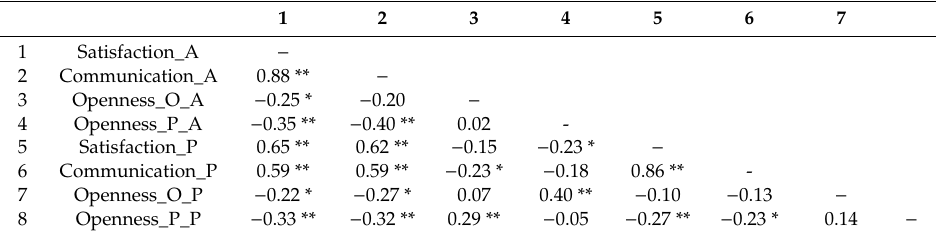
Table 2. Pearson’s correlations between satisfaction, communication and